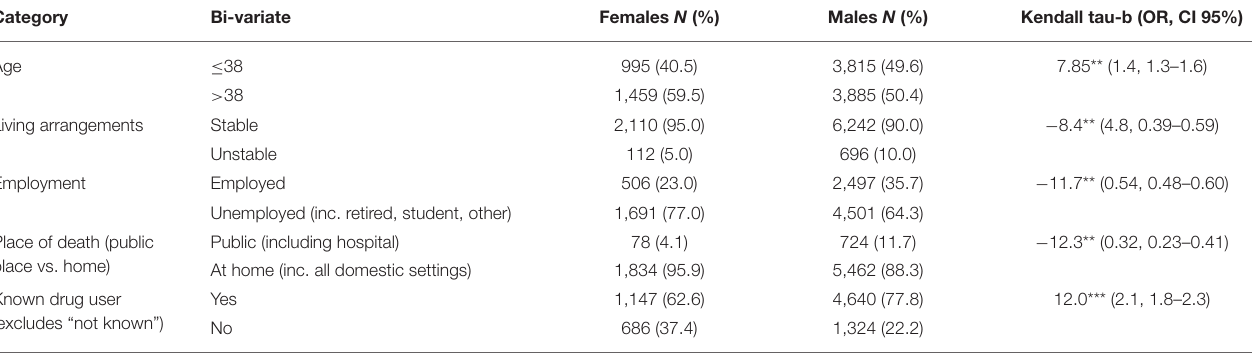
Place of death (public place vs. home)